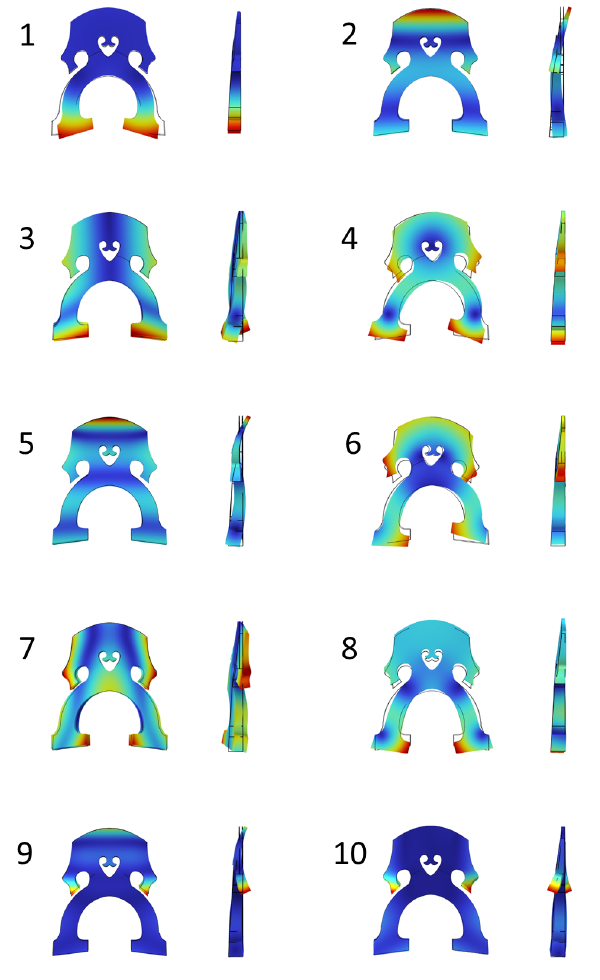
Figure A2. Mode shapes in free boundary conditions (case (a)) for the Normal